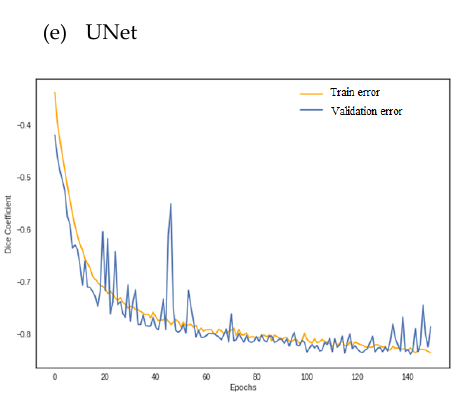
Figure 6. Training and validation learning curve per model: ( a ) FCN-32s; ( b ) FCN-16s; ( c ) SegNet; ( d ) multispectral SegNet; ( e ) UNet.